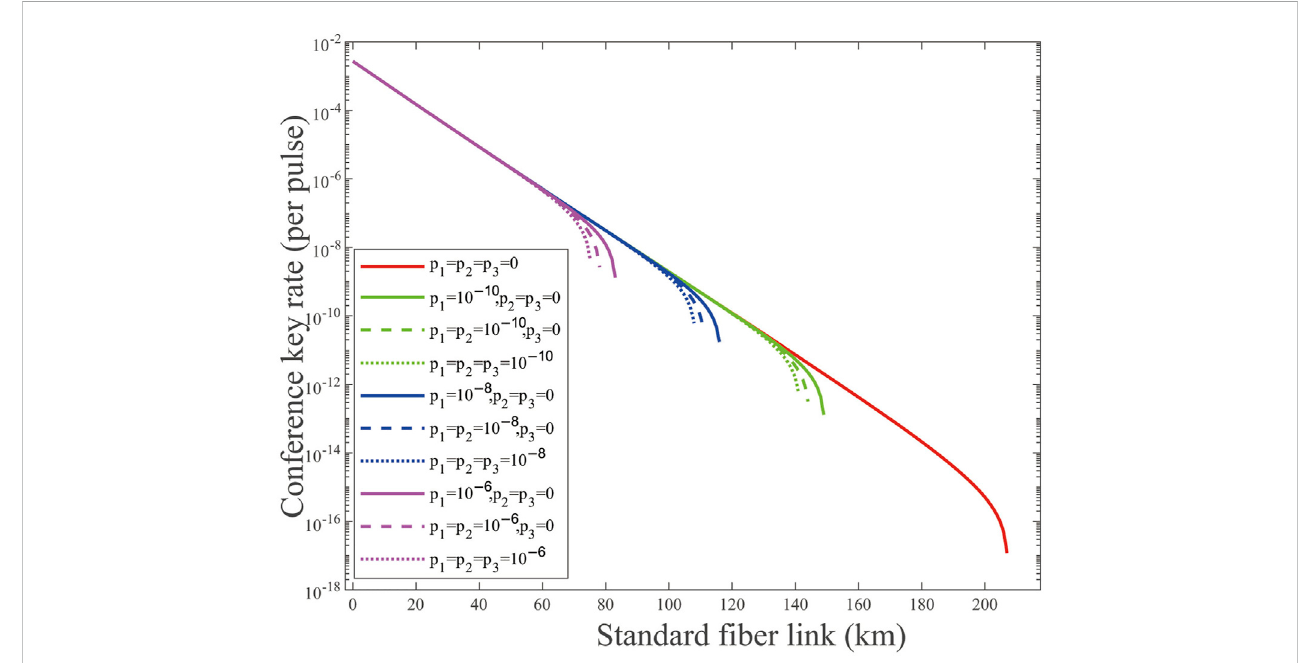
FIGURE 1 (Color online) Conference key rate (per pulse) on a logarithmic scale vs. transmission distance in the asymptotic case for p 1,2,3 = 0, 10 − x ( x = 10, 8, 6). The solidlinesaretheresultsofweakrandomnessexisting inoneparty,thedashedlinesaretheresultsofweak randomnessexistingintwoparties, andthedotted lines are the results of weak randomness existing in three